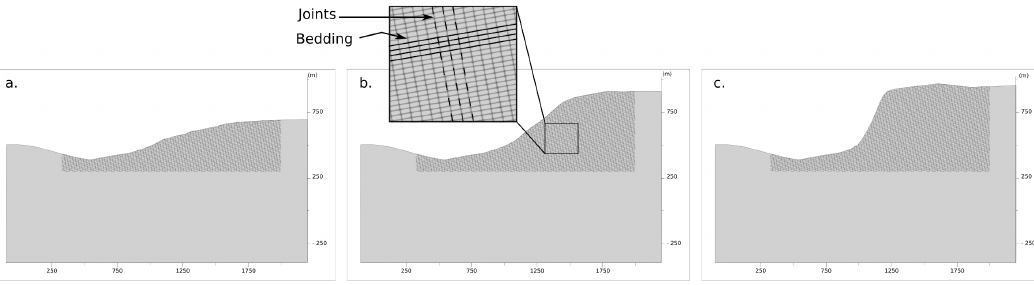
Figure 12. Cross section A–B of the Balta rockslide (location marked by the red line in the left figure with the estimated debris mass coloured in green) and its reconstructed pre-failure topography (dashed line).